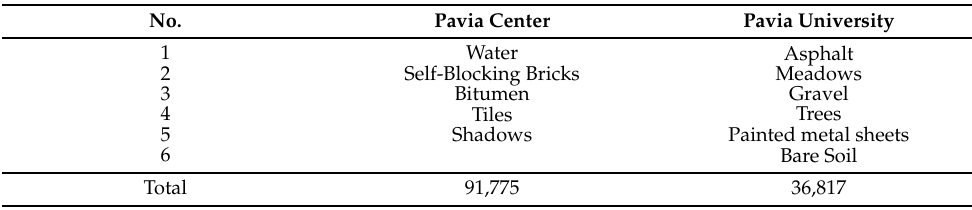
Table 3. The selected categories of Pavia Center dataset and Pavia University dataset for Case 3 and Case